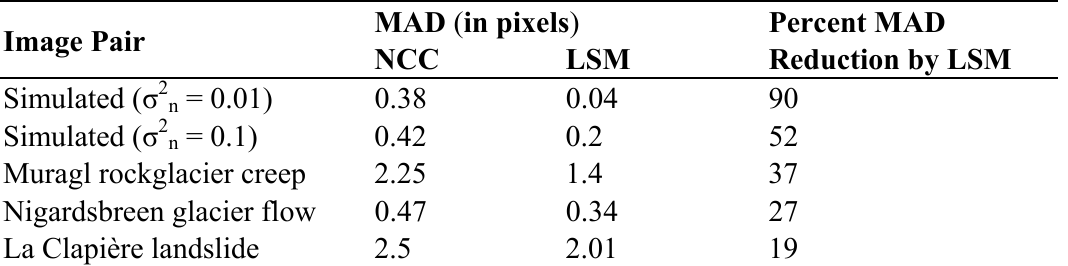
Table 4. The MAD of the errors of displacement on the simulated deformation images and the stable grounds of the real mass movement